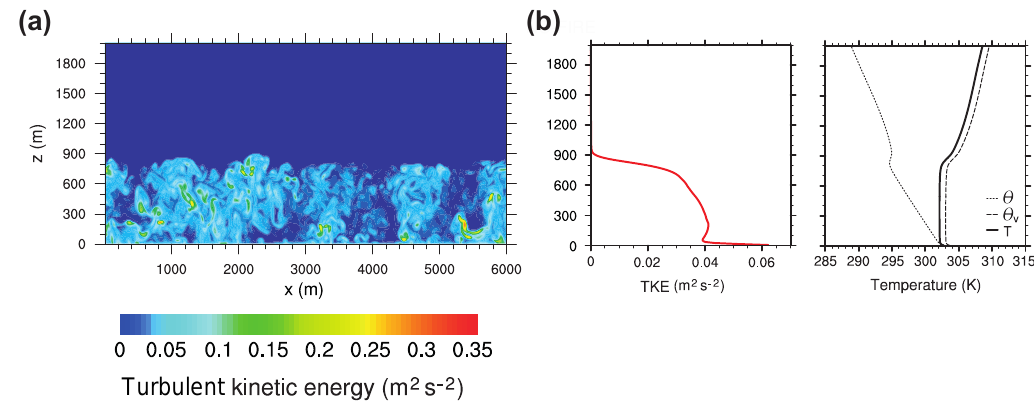
Figure 3. (a) Vertical cross section of the TKE for the NO-FIRE simulation after 2h of spin-up time; (b) averaged vertical profiles of the TKE (left panel), the absolute temperature T , potential temperature θ , and virtual potential temperature θ v (right panel) for the NO-FIRE